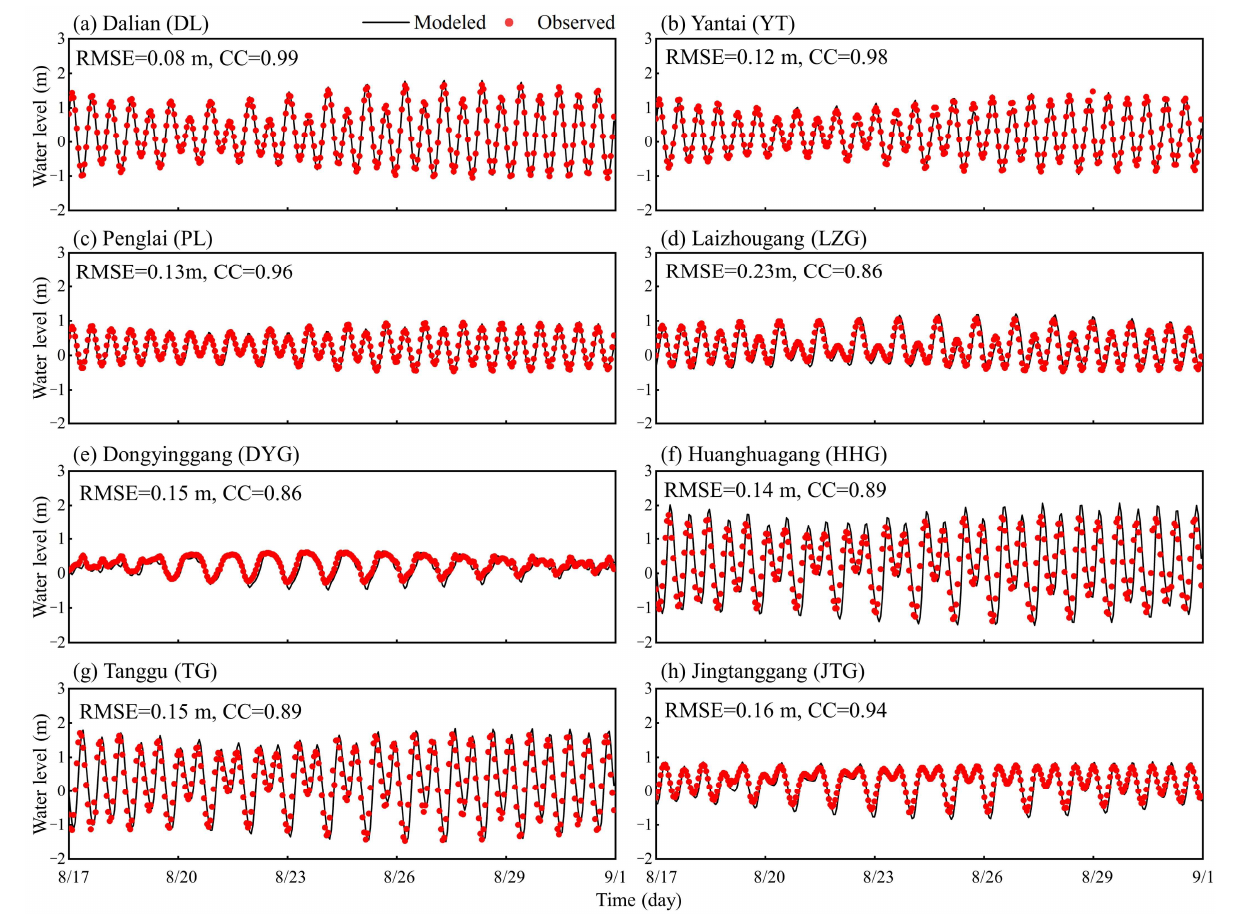
Figure 4. Comparison of modeled and observed water levels at eight tide gauge stations: ( a ) Dalian, ( b ) Yantai, ( c ) Penglai, ( d ) Laizhougang, ( e ) Dongyinggang ( f ) Huanghuagang, ( g ) Tanggu, and ( h ) Jingtanggang.